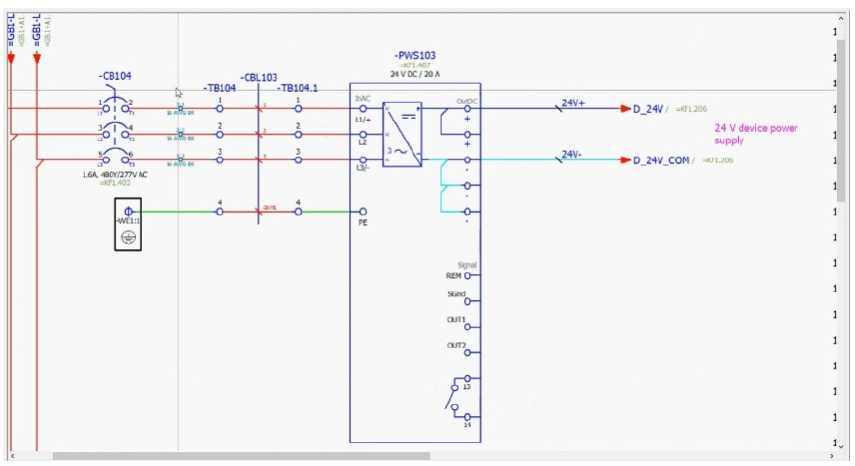
Figure 1. The control cabinet design in a CAD program—EPLAN Pro Panel 2.7 used in this case.